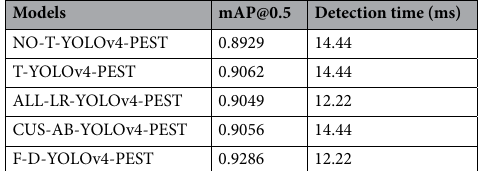
Table 9. Basic performance indicators of each model.